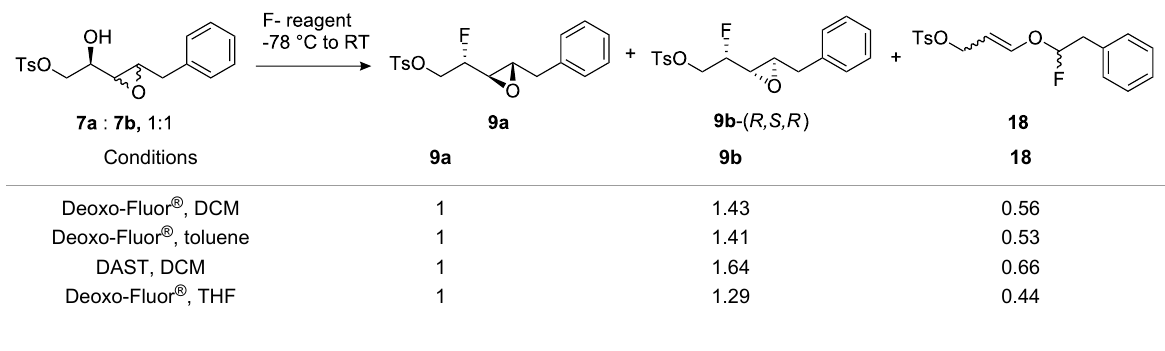
Table 1: Reaction of α,β-epoxy alcohol 7a and 7b under various fluorination conditions. Ratios determined by 19 F